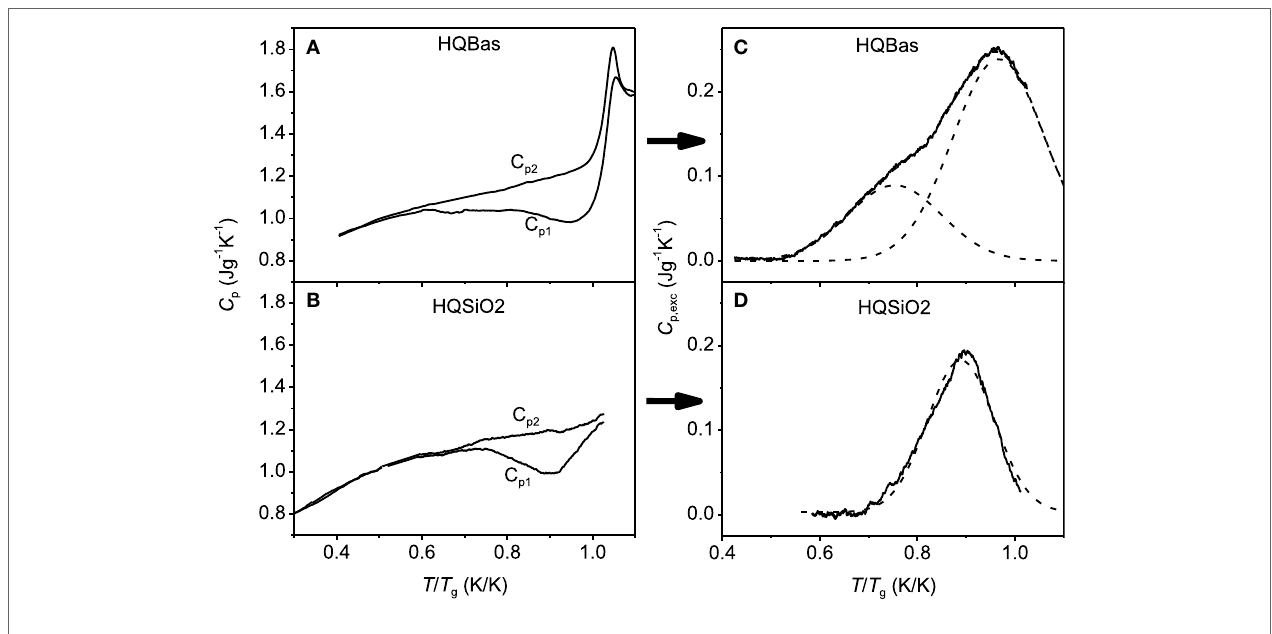
during the second upscan at 20 K/min. Right panel : Comparison in the excess heat capacity C p,exc ( = C p2 − C p1 ) as a function of T/T g between (c) HQBas and (D) HQSiO 2 . Solid lines represent the measured C p,exc curves, while the dashed lines represent the Gaussian fits. The C p,exc peak of HQBas is the sum of two Gaussian peaks, whereas that of HQSiO 2 is described by one Gaussian